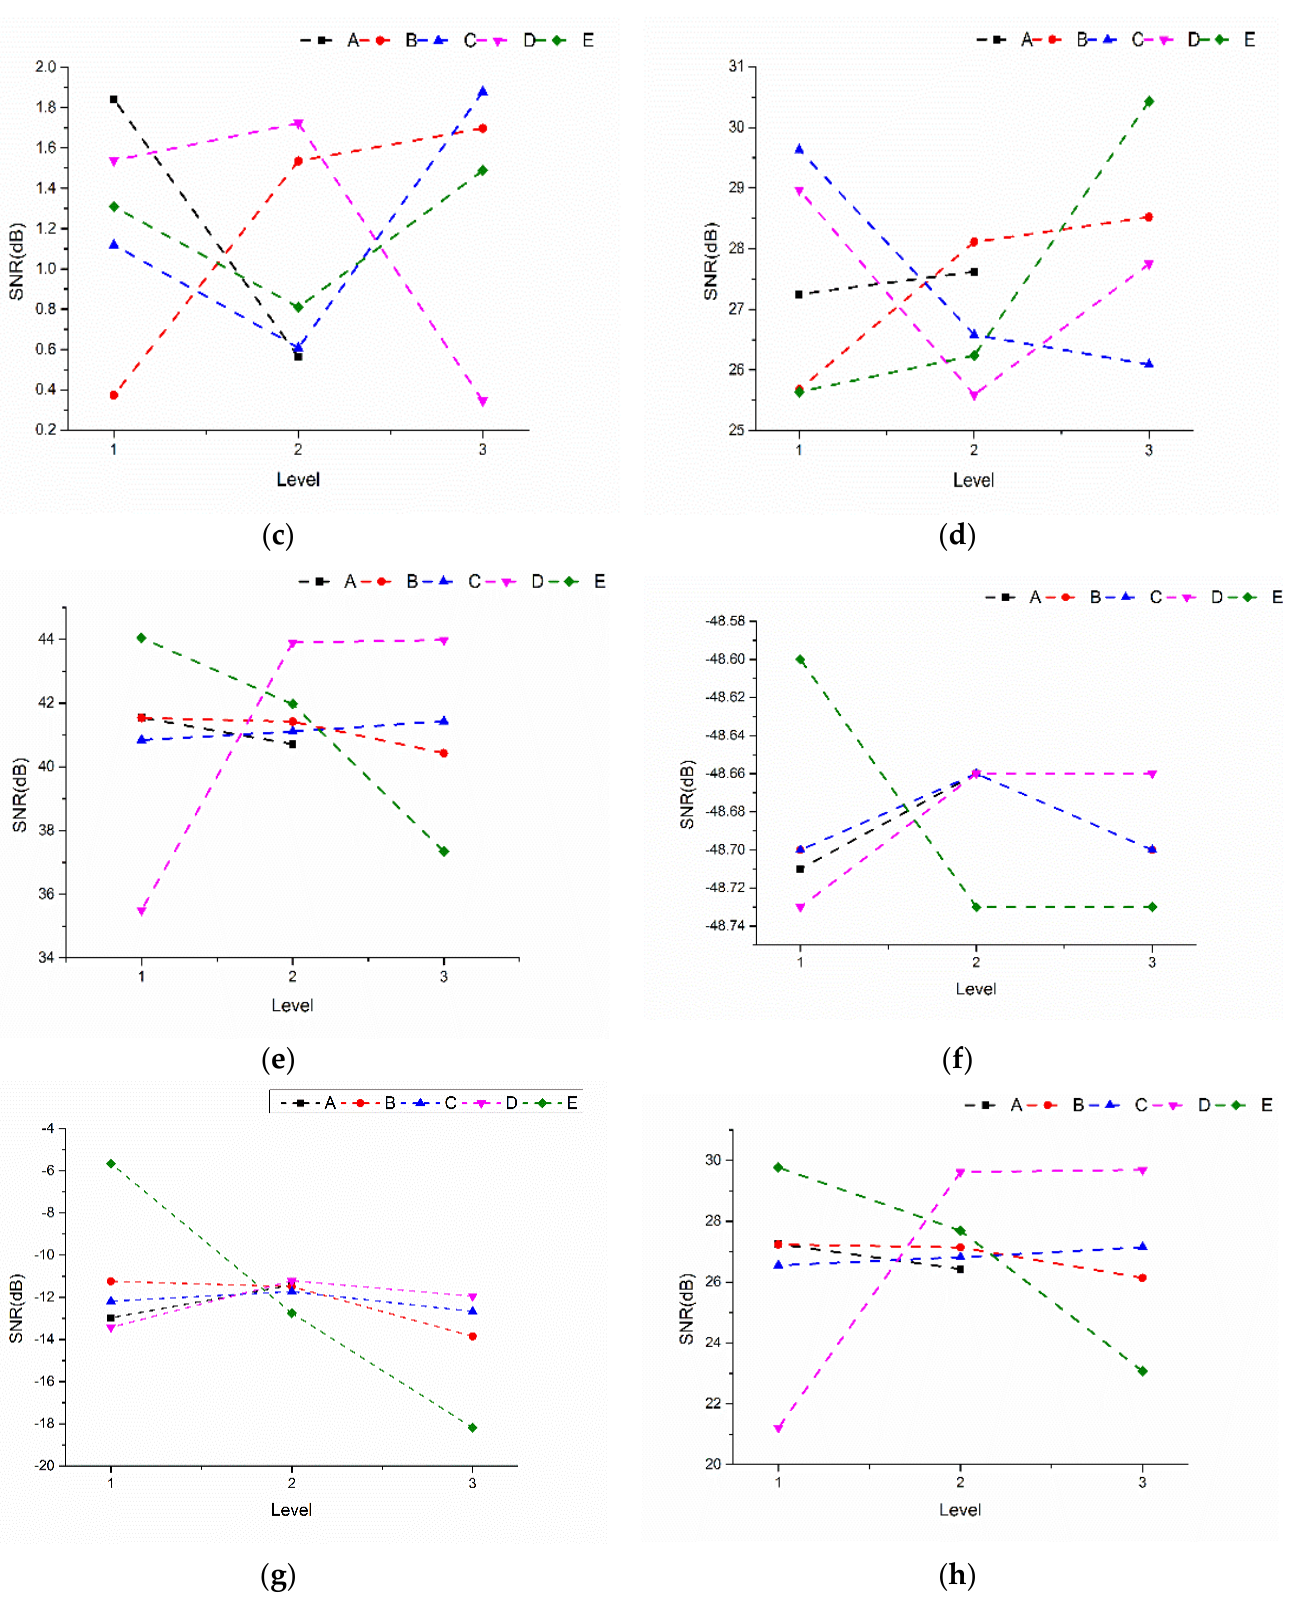
Figure 5. Mean effects plot: ( a ) W, ( b ) OW, ( c ) OL, ( d ) T, ( e ) carbon dioxide emissions, ( f ) material cost, ( g ) labor cost, ( h ) electricity cost. Table 5. Optimal factors of all single objectives.